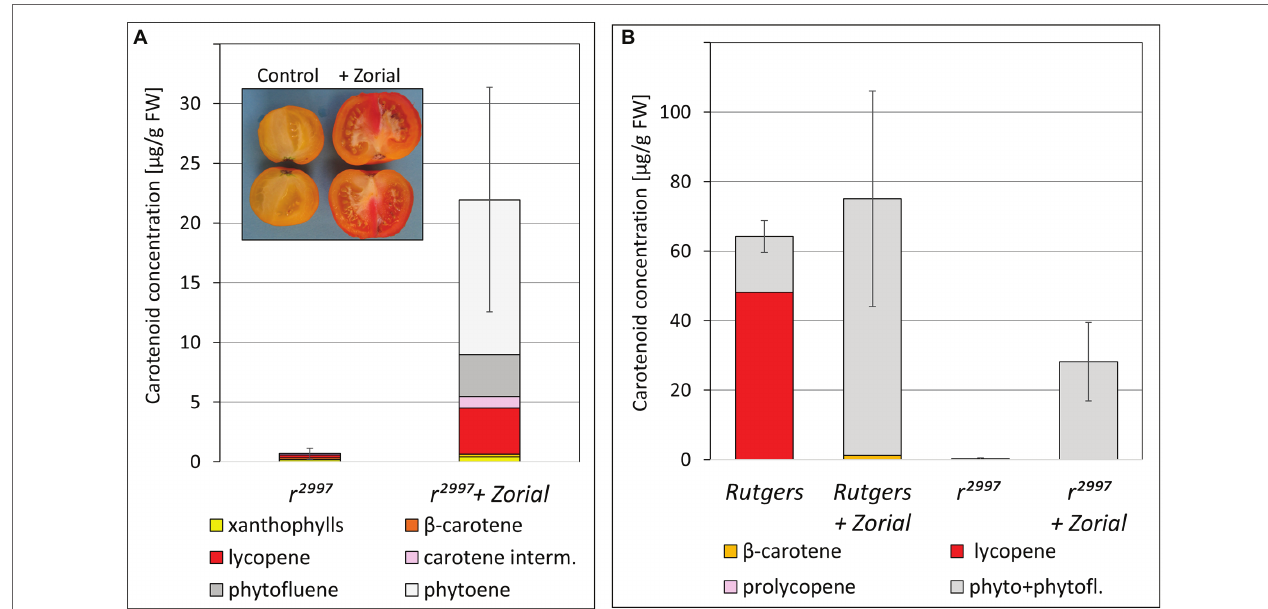
FIGURE 4 | Effects of norflurazon (Zorial) on pigment accumulation in the fruit of yellow flesh r 2997 (Rutgers variety background). (A) Carotenoid composition in fruits after Zorial injection. (B) Carotenoid composition in pericarp explants from Rutgers (wild type) and mutant r 2997 treated with Zorial (Z).